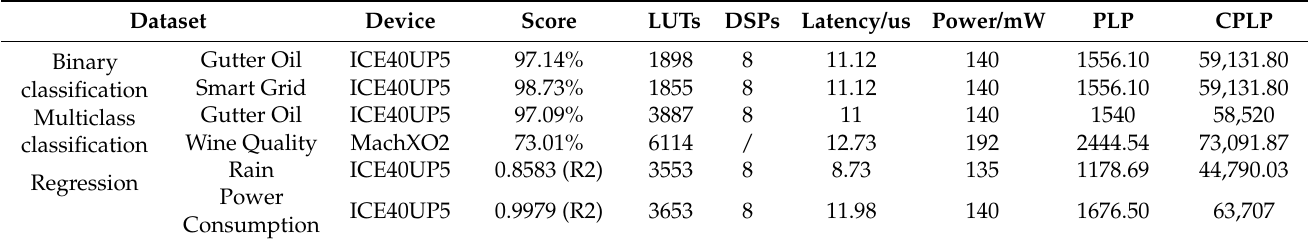
Table 8. ANN deployment results on the best CPLP-performing FPGAs.